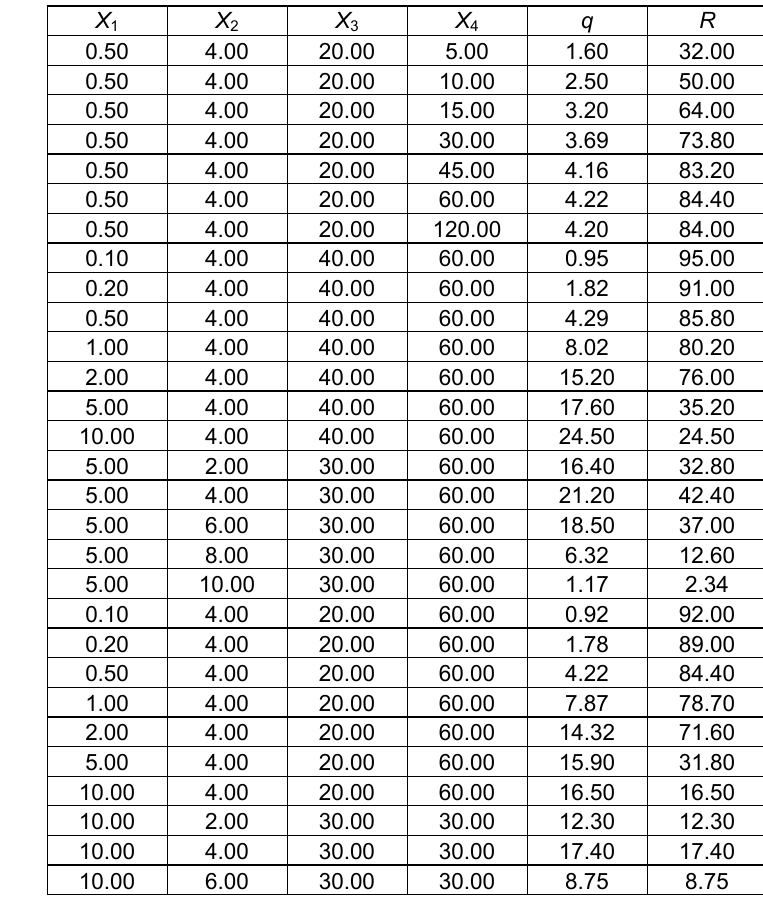
Table 4 – Results of 29 experiments for the adsorption of arsenite on CSHAp Таблица 4 – Результаты 29 экспериментов по адсорбции арсенита на